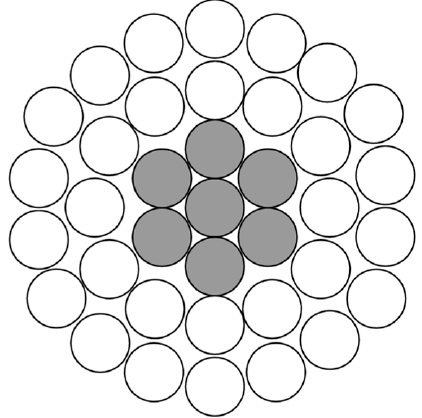
Figure 1. Cross section of the ACSR conductor.